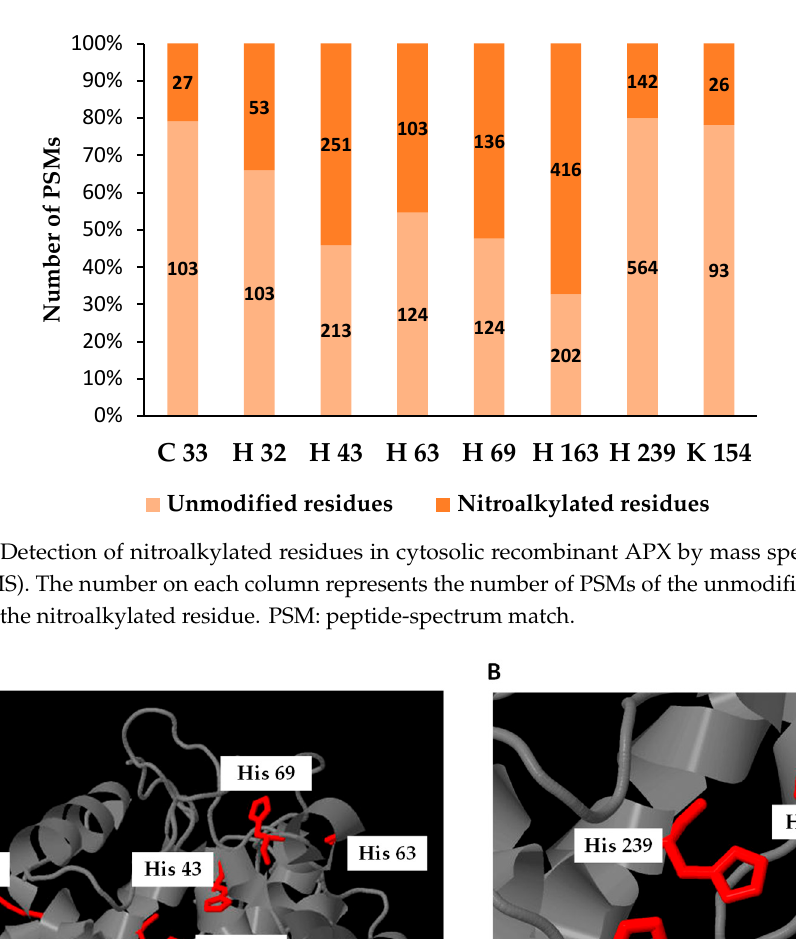
(Ascorbate peroxidase: APX). linolenic acid (non-nitrated fatty acid) were used. Vertical bars represent the mean ± standard deviation of at least three replicates. Statistically significant differences p < 0.05 (*) and p < 0.01 (**).